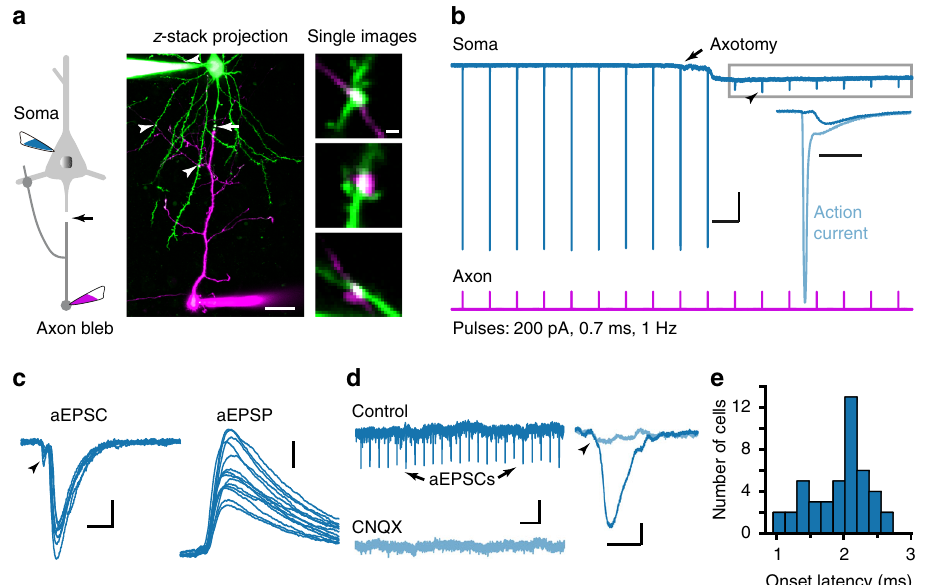
Fig. 1 Layer-5 PCs form functional autapses. a Left, schematic drawing of dual soma and axon-bleb recording with two-photon laser axotomy (black arrow) just beyond the axon initial segment. Middle, an example image showing dual recording and axotomy (white arrow) in a layer-5 PC (scale bar: 50 μ m). Patch pipettes for the soma and the axon were fi lled with internal solutions containing Alexa Fluo-488 (green) and -594 (magenta) fl uorescent dyes, respectively. Due to the block of dye diffusion after axotomy, the two dyes accumulated in somatodendritic and axonal compartments, respectively. Arrowheads indicate putative autaptic contacts. Right, higher magni fi cation of the contacts (scale bar: 2 μ m). b A representative recording. Axon stimulation evoked action currents at the soma ( V hold : − 70 mV). After axotomy (arrow), AP backpropagation was blocked as indicated by the absence of somatic action currents. Inset, overlay of an action current and a residual current (arrowhead). Scale bars: 1 s/1 nA (inset, 5 ms). c Overlay of somatic responses to axon stimulation in voltage-clamp mode (left, current traces from the gray box in b) and current-clamp mode (right). Note the occurrence of aEPSCs and aEPSPs. The initial current de fl ections (arrowhead) indicate the arrival of backpropagating APs through the incomplete axotomy site.